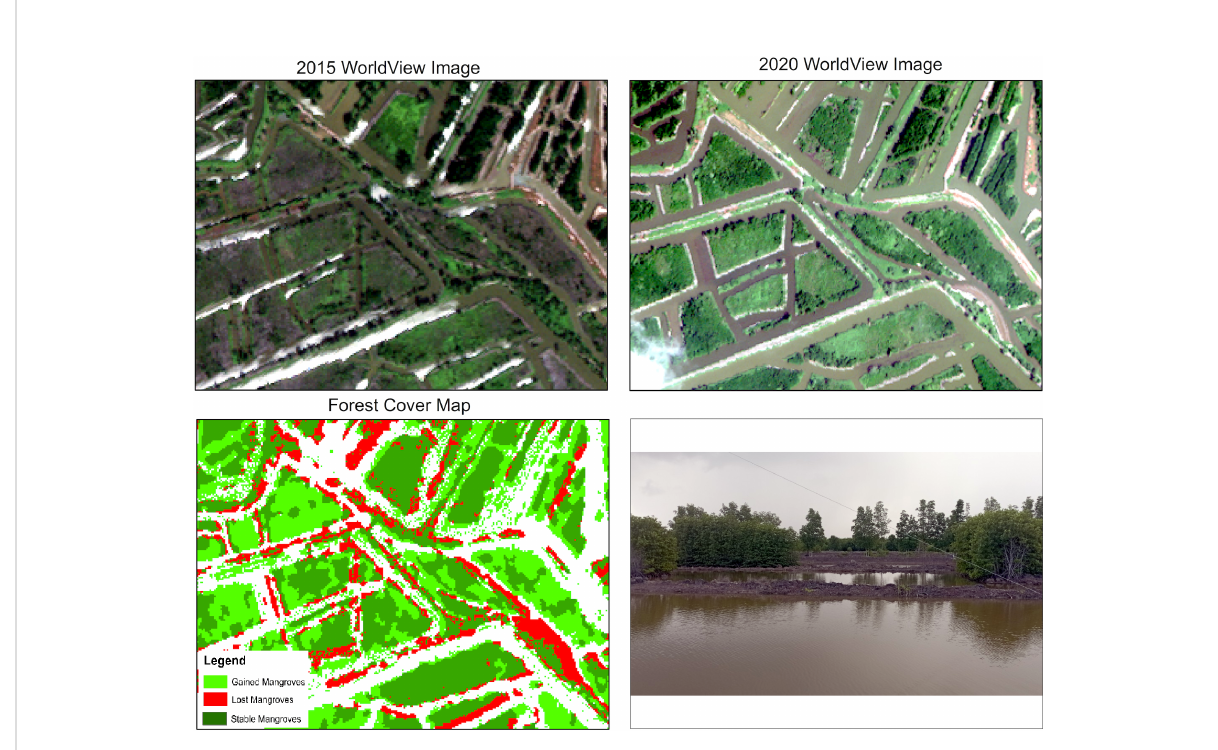
FIGURE 7 Mangrove loss in a integrated mangrove aquaculture